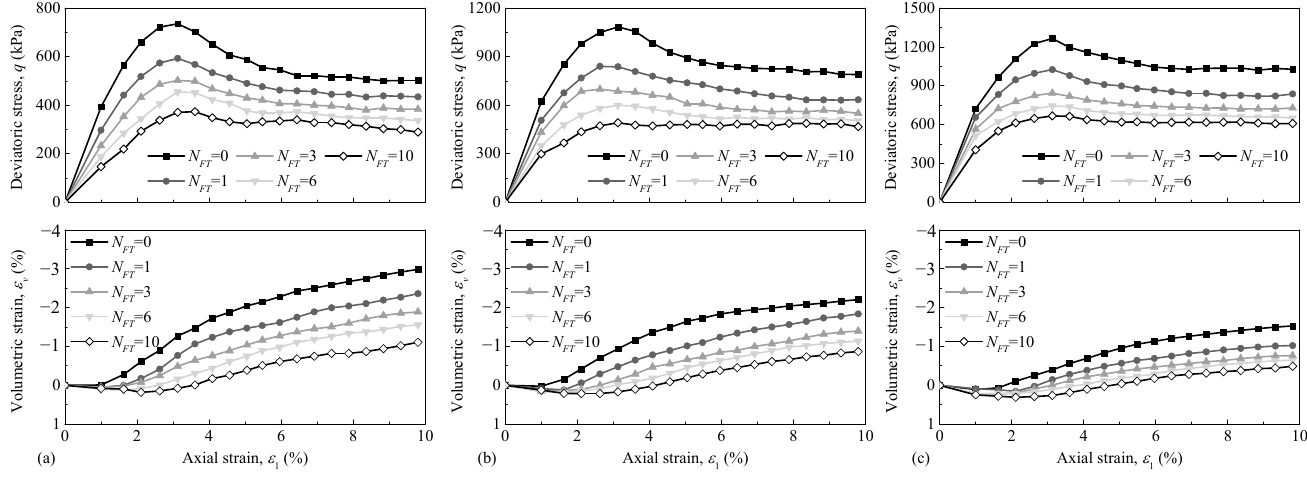
Figure 2. Dependence of deviatoric stress and volumetric strain on axial strain of tested CGS corre- sponding to different numbers of FTCs (modified after Ling et al. [18]): ( a ) σ 3 = 30 kPa, ( b ) σ 3 = 60 kPa, and ( c ) σ 3 = 90 kPa.